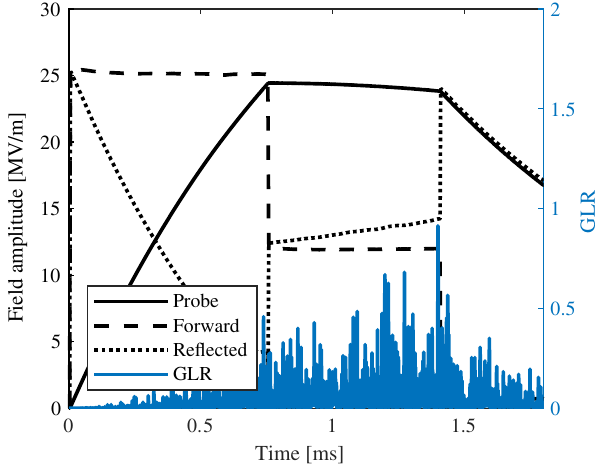
FIG. 15. Cavity signals and corresponding GLR when the detuning is changed.